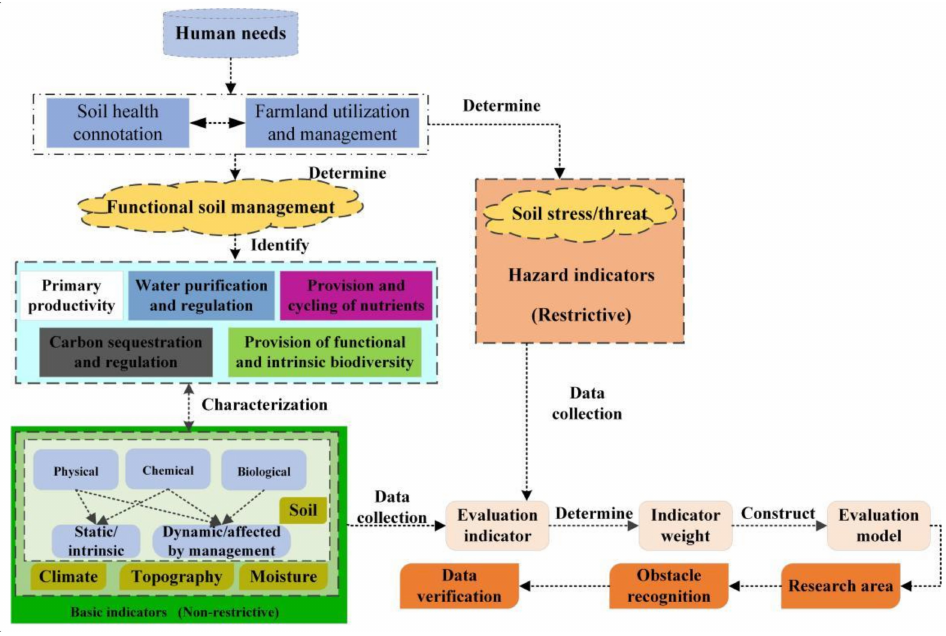
Figure 1. Research